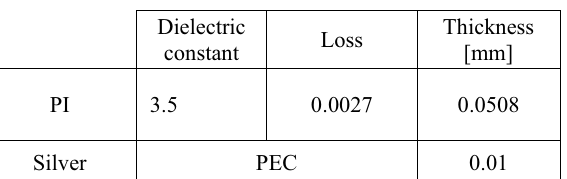
Fig.3. The proposed RFID TAG design. Table .1. Material Specification